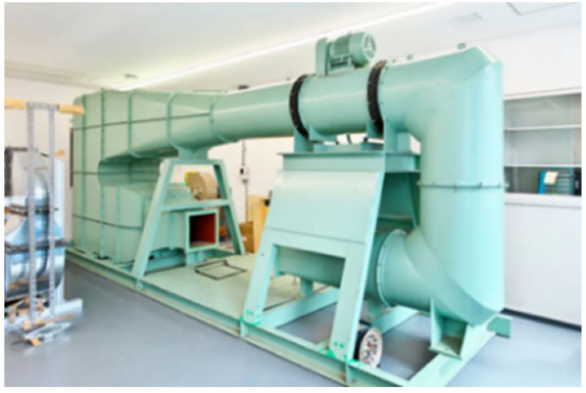
Figure 3. Circulating wind